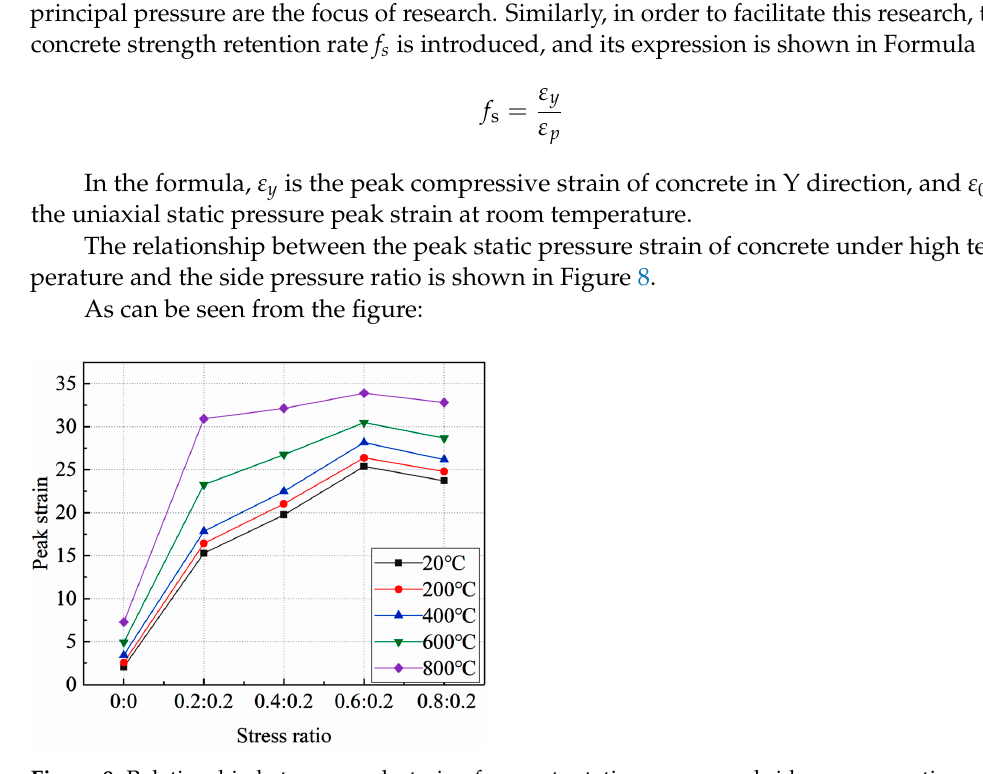
Figure 8. Relationship between peak strain of concrete static pressure and side pressure ratio. The relationship between concrete static pressure peak strain and temperature under different lateral pressure ratios is shown in Figure 9.